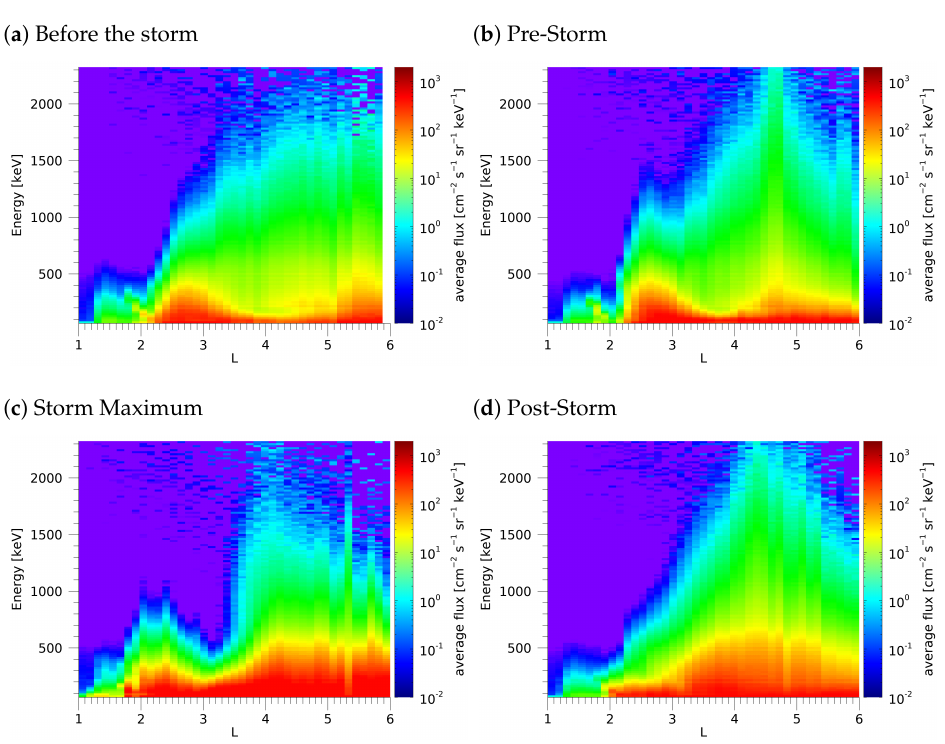
Figure 6. The same as Figure 5, but for Type 2